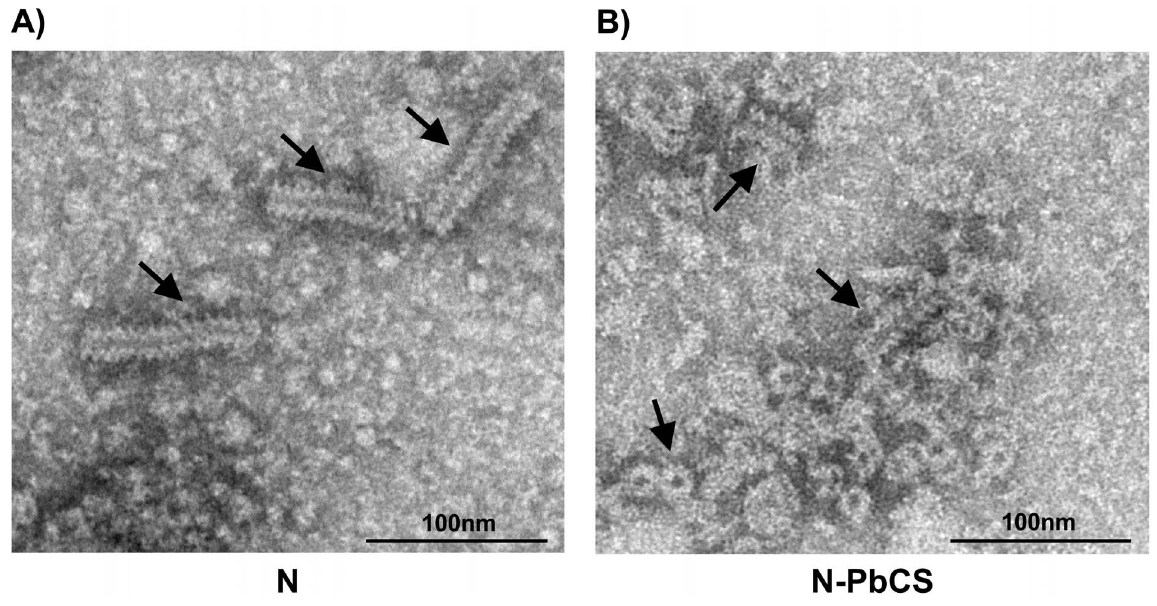
Figure 4. Electron microscopy analysis of yeast lysates from SMD1168 P.pastoris expressing N (A) or N-PbCS (B). Scale bars are indicated. Black arrows highlight RNP rod and ring